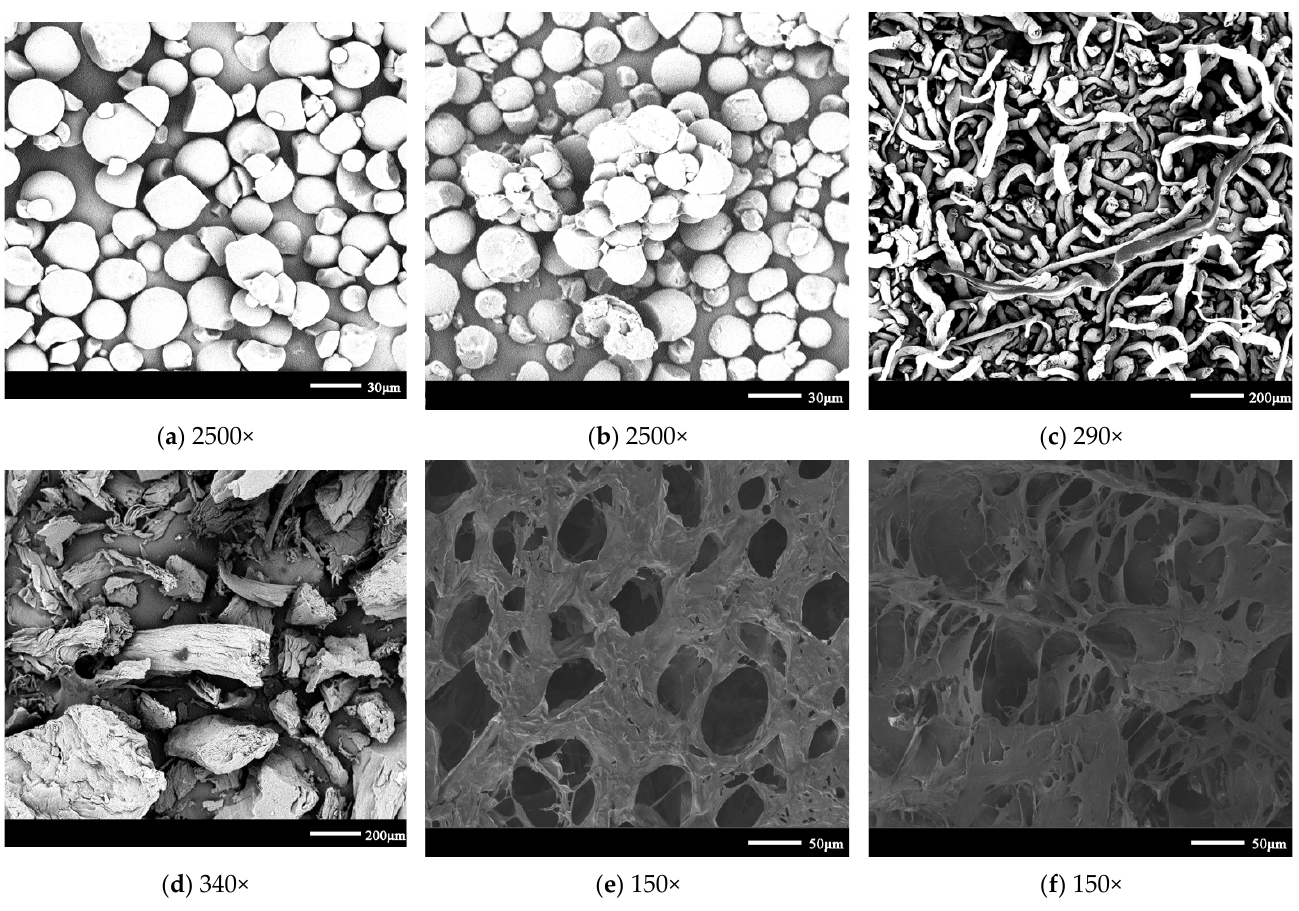
Figure 7. Scanning electron microscopy: ( a ) cassava starch, ( b ) cassava starch after dry thermal modification, ( c ) carboxymethyl cellulose, ( d ) quaternized carboxymethyl cellulose, ( e ) surface of hydrogel, and ( f ) cross-section of hydrogel.